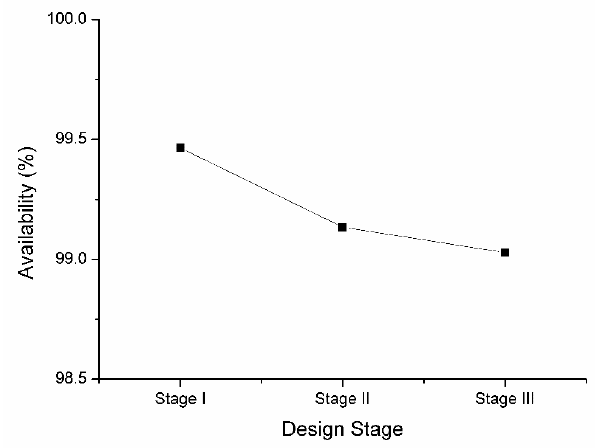
Figure 13. Availability depending on the stages.